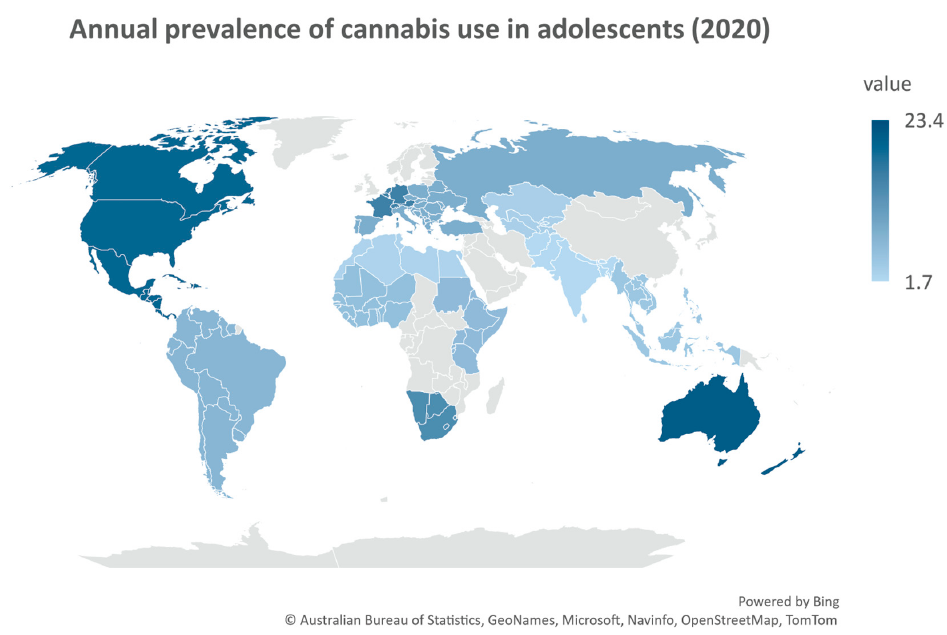
Figure 2. A blue-scale representation of the prevalence (percentage) of cannabis use in adolescents (aged 15–16) by country in 2020. Data were adapted from World Drug Report 2022, Statistical An- nex Tables.